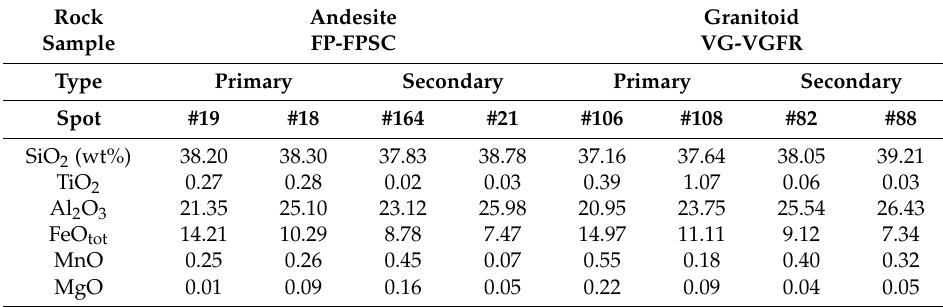
Table 2. Representative Electron Microprobe analyses and chemical formulae of epidote from Isadalu magmatic